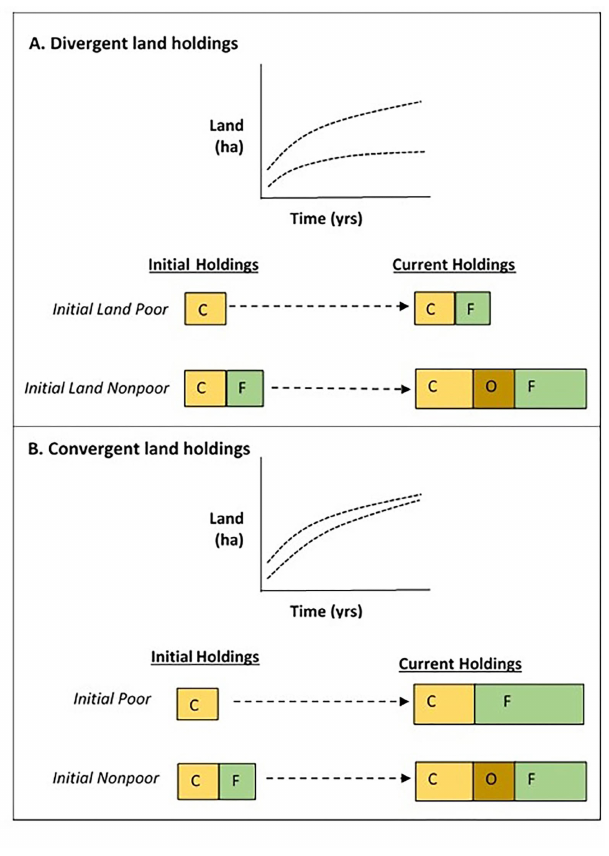
Fig. 1 . Household land accumulation and land use/cover outcomes for divergent and convergent household land accumulation trajectories (C: crop; O: orchard; F: fallow